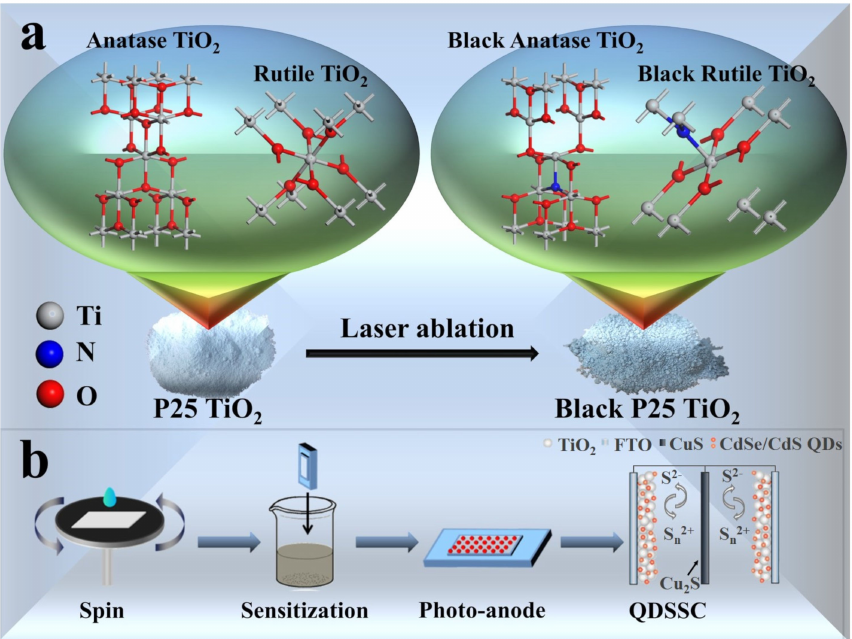
Figure 1. ( a ) Schematic illustration of structures of pristine and black TiO 2 ; ( b ) Fabrication procedure and working principle of